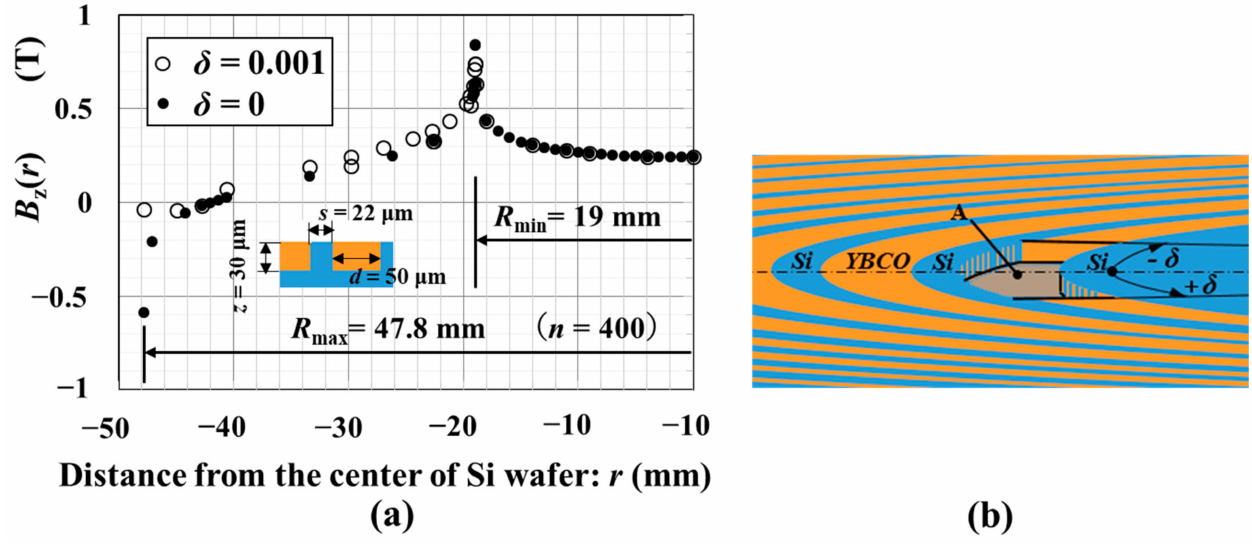
Figure 6. ( a ) Radial distribution of the calculated magnetic flux density B z ( r ) normal to the wafer coil on the surface of the Si wafer of 2 R wafer = 101.6 mm and t = 0.5 mm. The principal design parameters of the spiral coil, d , s , z , R max , n , and R min , are indicated in the inserts of the figure. ( b ) The volume portion within ± δ radian removed in the circular trench from the integration in Equation (3) to calculate B z ( r ) at position A at the half width and at the half depth in the trench so that r does not become equal to q .